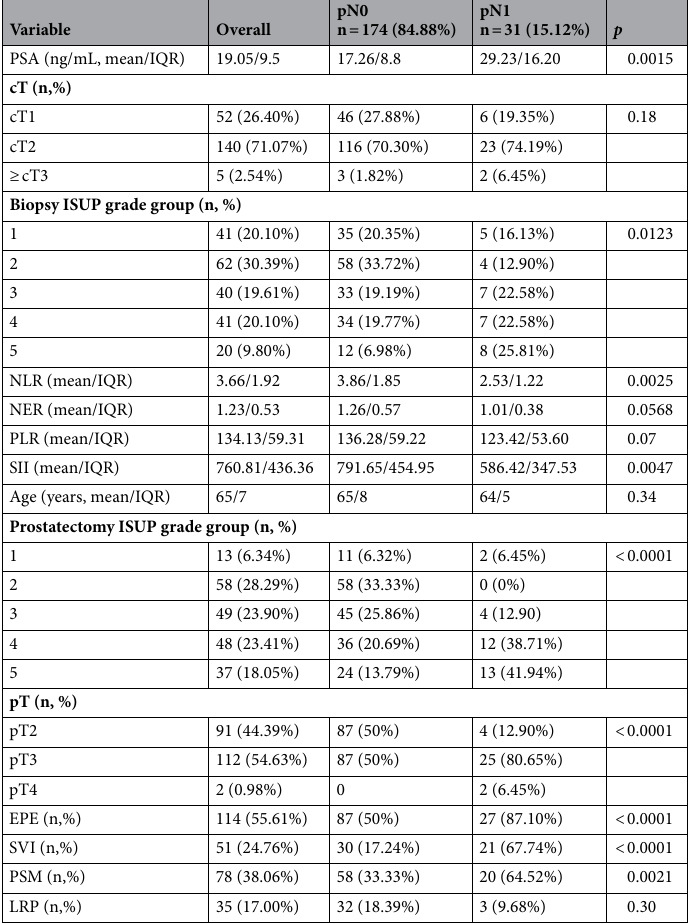
Table 1. Baseline characteristics of patients stratified by nodal status in the postprostatectomy specimen. cT clinical staging, EPE extracapsular extension, IQR interquartile range, LRP laparoscopic radical prostatectomy, NER neutrophil-to-erythrocyte, NLR neutrophil-to-lymphocyte ratio, PLR platelet-to-lymphocyte ratio, pN pathological nodal staging, PSA prostate-specific antigen (ng/mL), PSM positive surgical margins, pT pathological local staging, SII systemic immune-inflammation index, SVI seminal vesicles